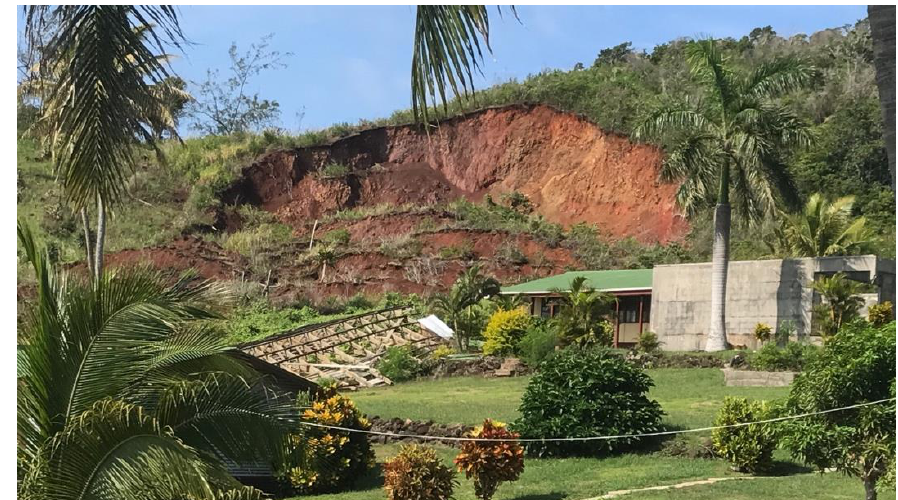
Figure 5. The landslide that destroyed the primary school in Denimanu village.